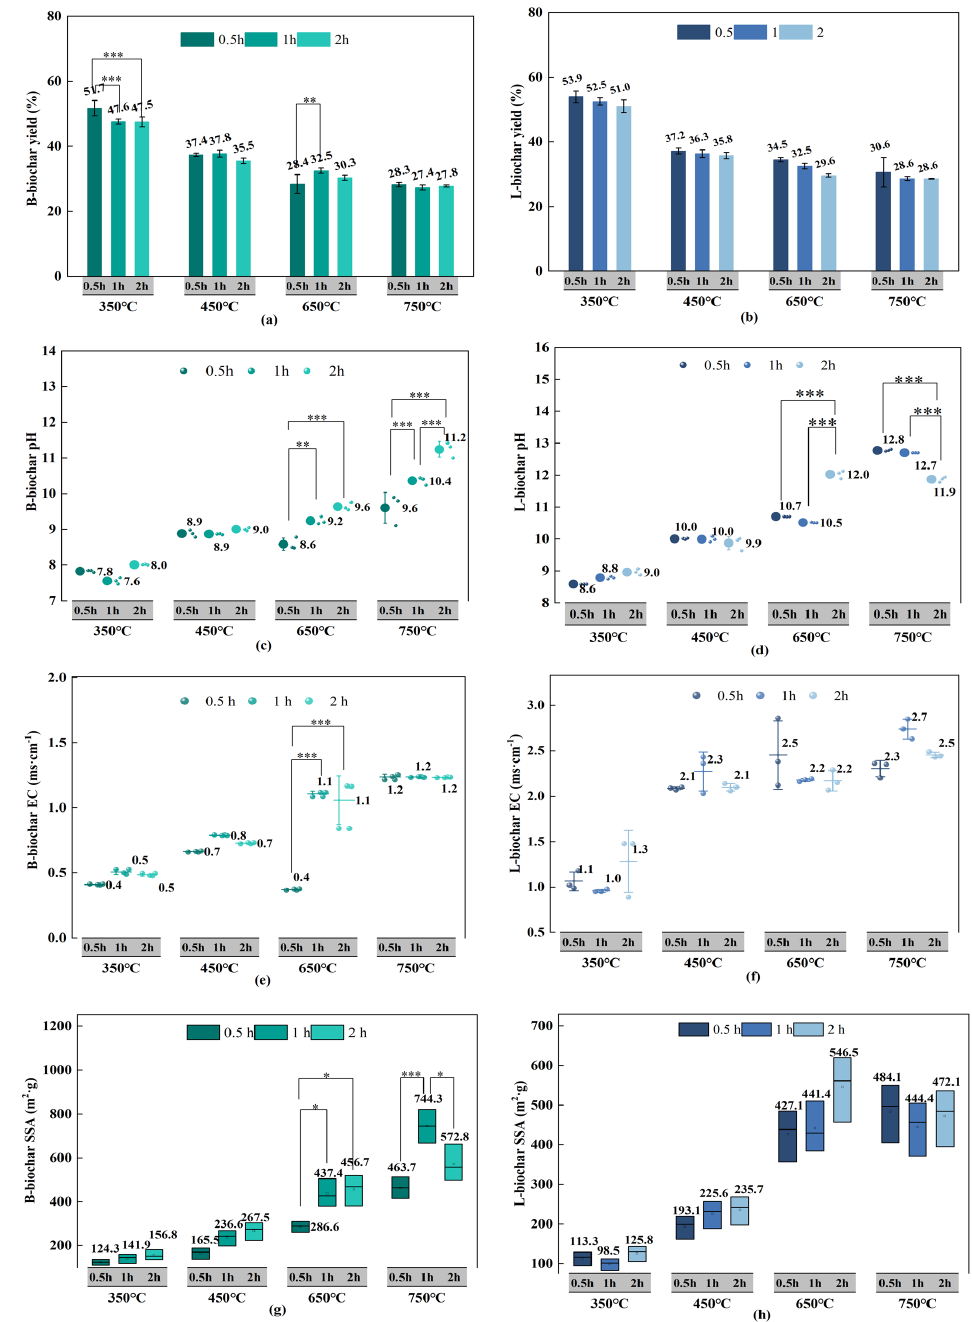
Figure 1. An illustration of how the yield, Ph, EC, and SSA of all manufactured biochar evolved with the time when the temperature was constant: ( a , c , e , g ) respectively indicate the yield, pH, EC and specific surface area (SSA)of B-biochar; while ( b , d , f , h ) indicate these properties of L-biochar; the significance was noted by * = p < 0.05, ** = p < 0.01 and *** = p < 0.001.